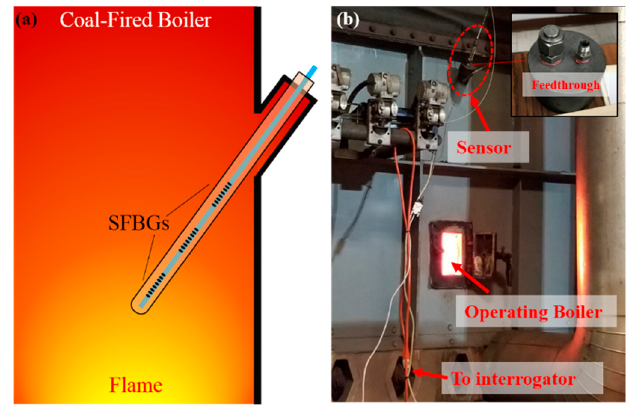
Figure 7. Sensor deployment in a coal-fired boiler: ( a ) scheme for the configuration of the sensor (thermocouple not shown); ( b ) picture of the deployment site.